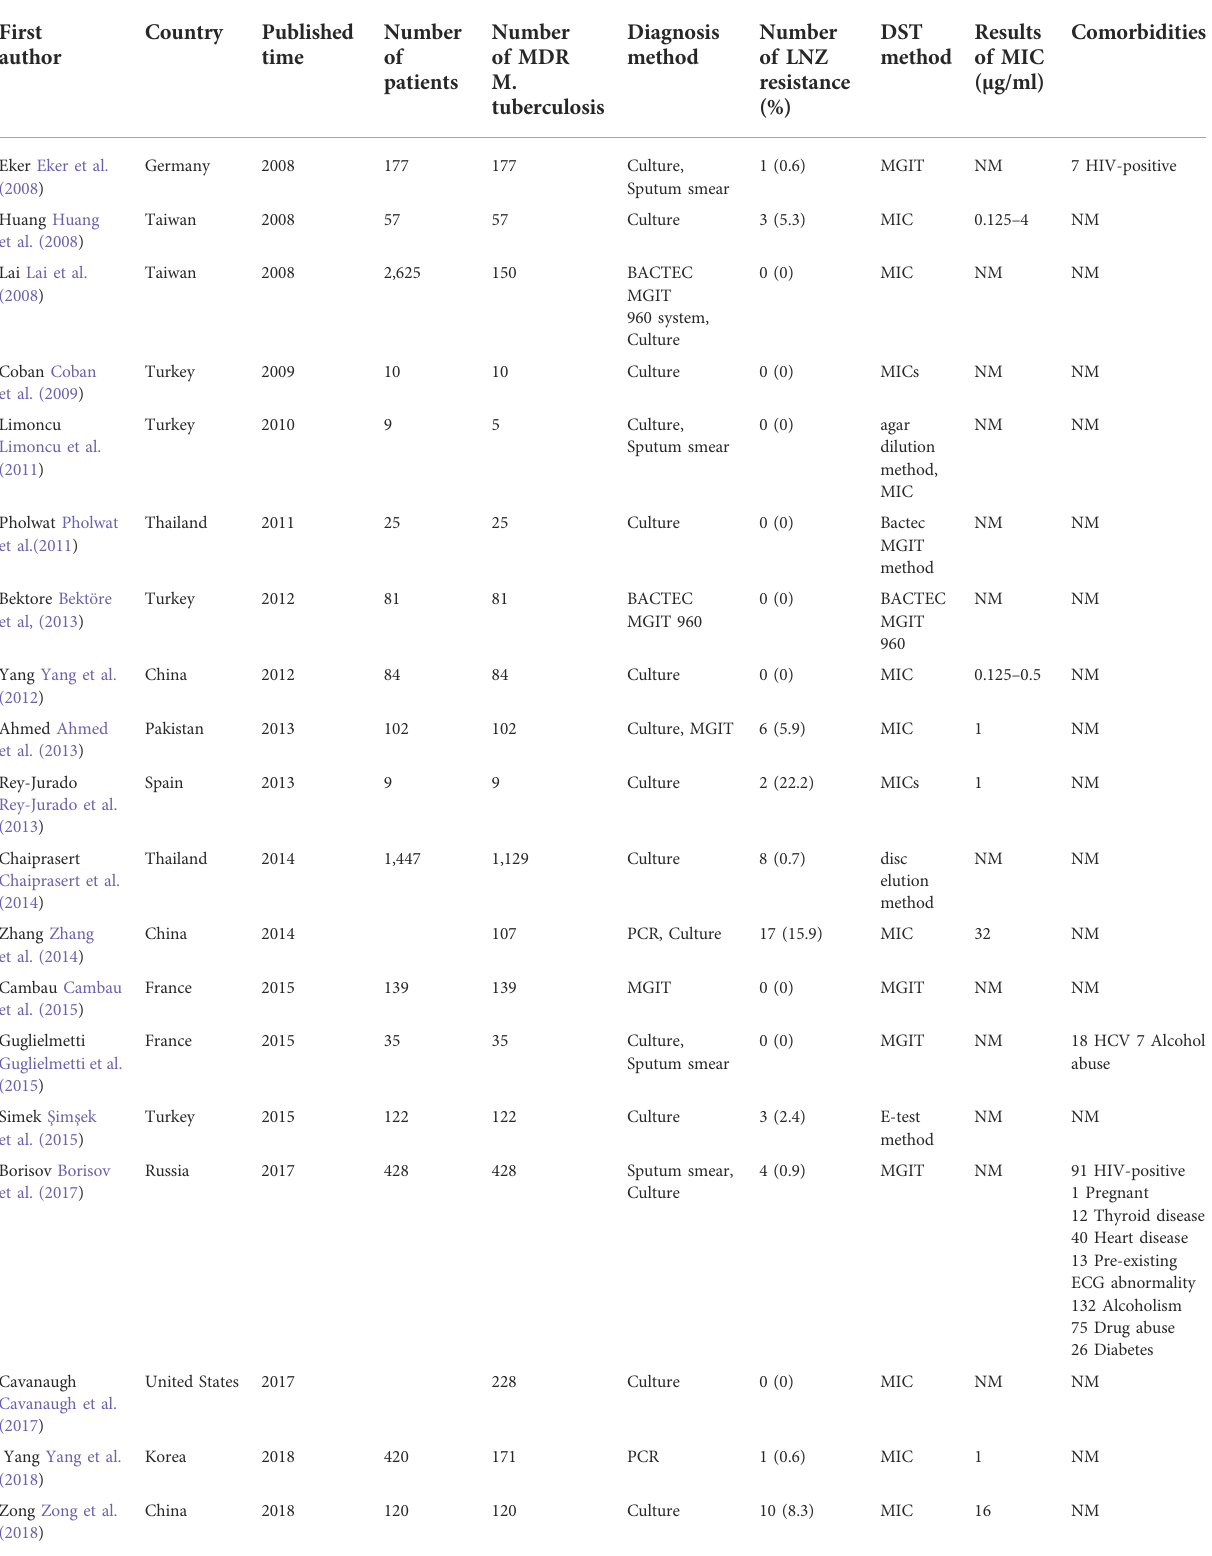
TABLE 1 Characteristics of the included